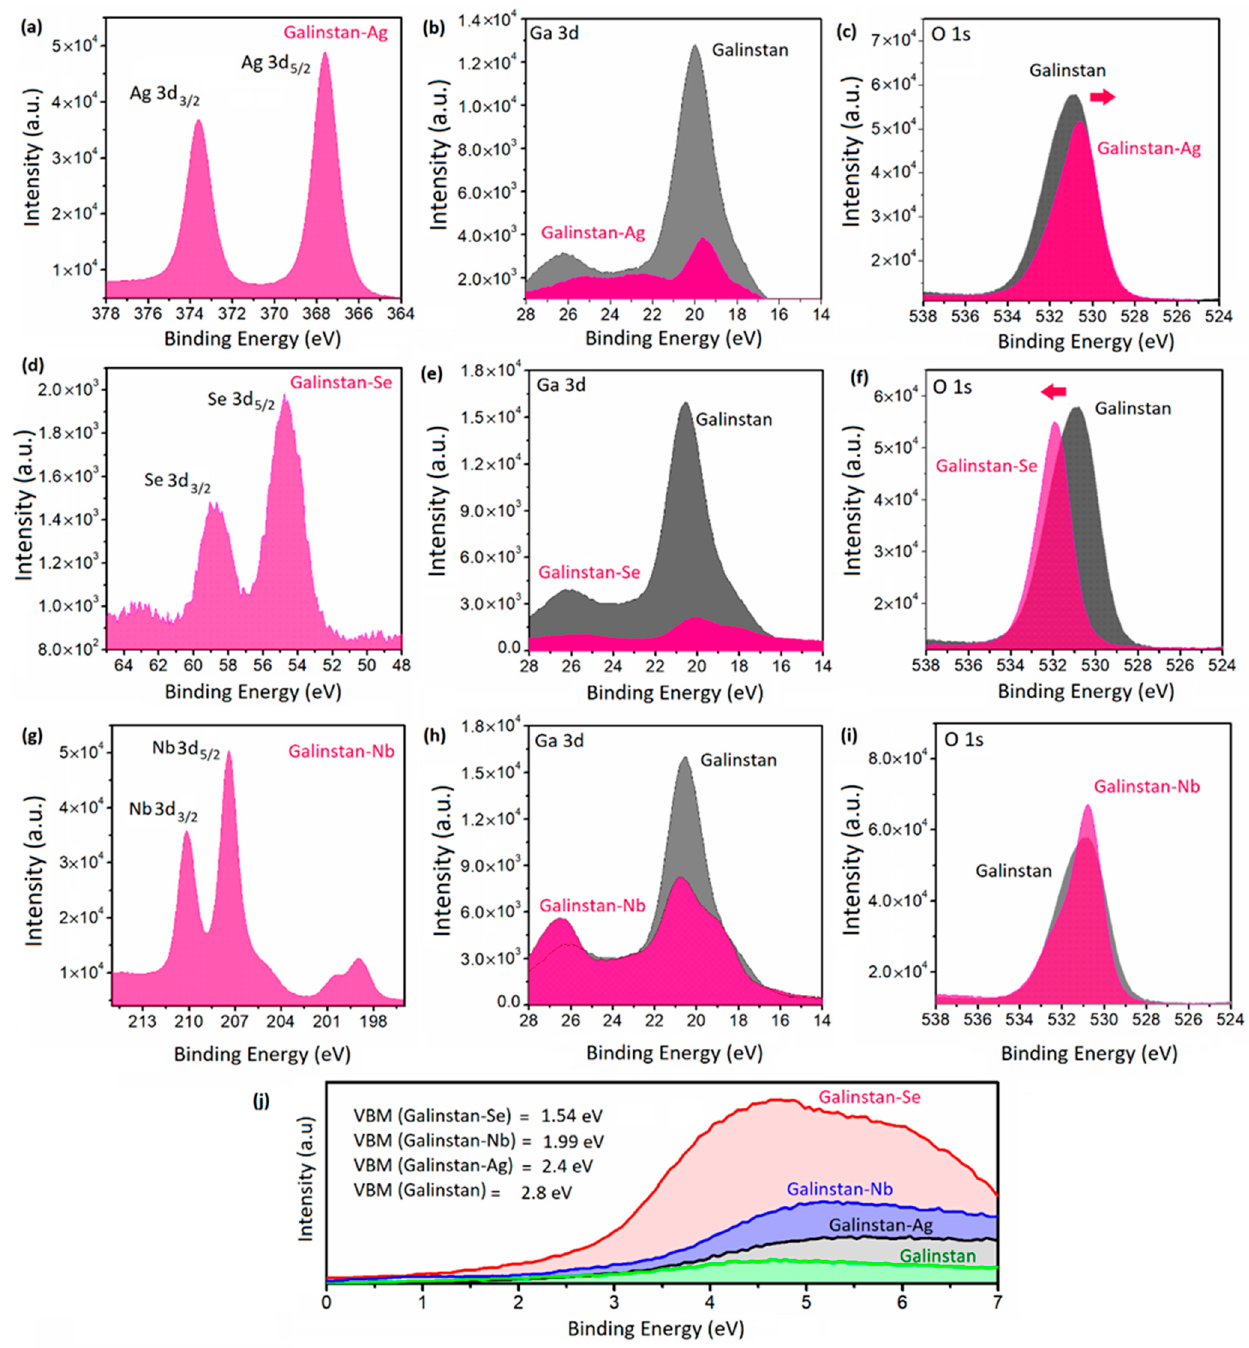
Figure 4. ( a ) The Ag 3d spectra of galinstan-Ag heterointerfaces. ( b ) The Ga 3d spectra of Ag 3d spectra of galinstan-Ag heterointerfaces. ( c ) The O 1s peak of galinstan-Ag heterointerfaces. ( d ) The Se 4d spectra of galinstan-Se heterointerfaces. ( e ) The Ga 3d spectra of galinstan-Ag heterointerfaces. ( f ) The O 1s peak of galinstan-Se heterointerfaces. ( g ) The Nb 3d spectra of galinstan-Nb heterointerfaces. ( h ) The Ga 3d spectra of galinstan-Se heterointerfaces. ( i ) The O 1s spectra of galinstan-Nb interfaces. ( j ) The VBM of hybrid 2D heterointerfaces.